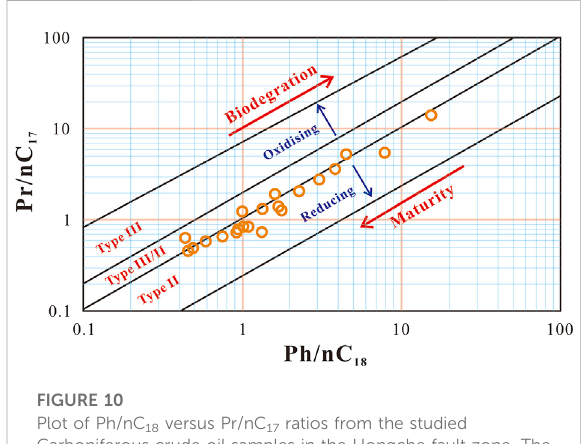
FIGURE 10 Plot of Ph/nC 18 versus Pr/nC 17 ratios from the studied Carboniferous crude oil samples in the Hongche fault zone. The base map modi fi ed from Shanmugam